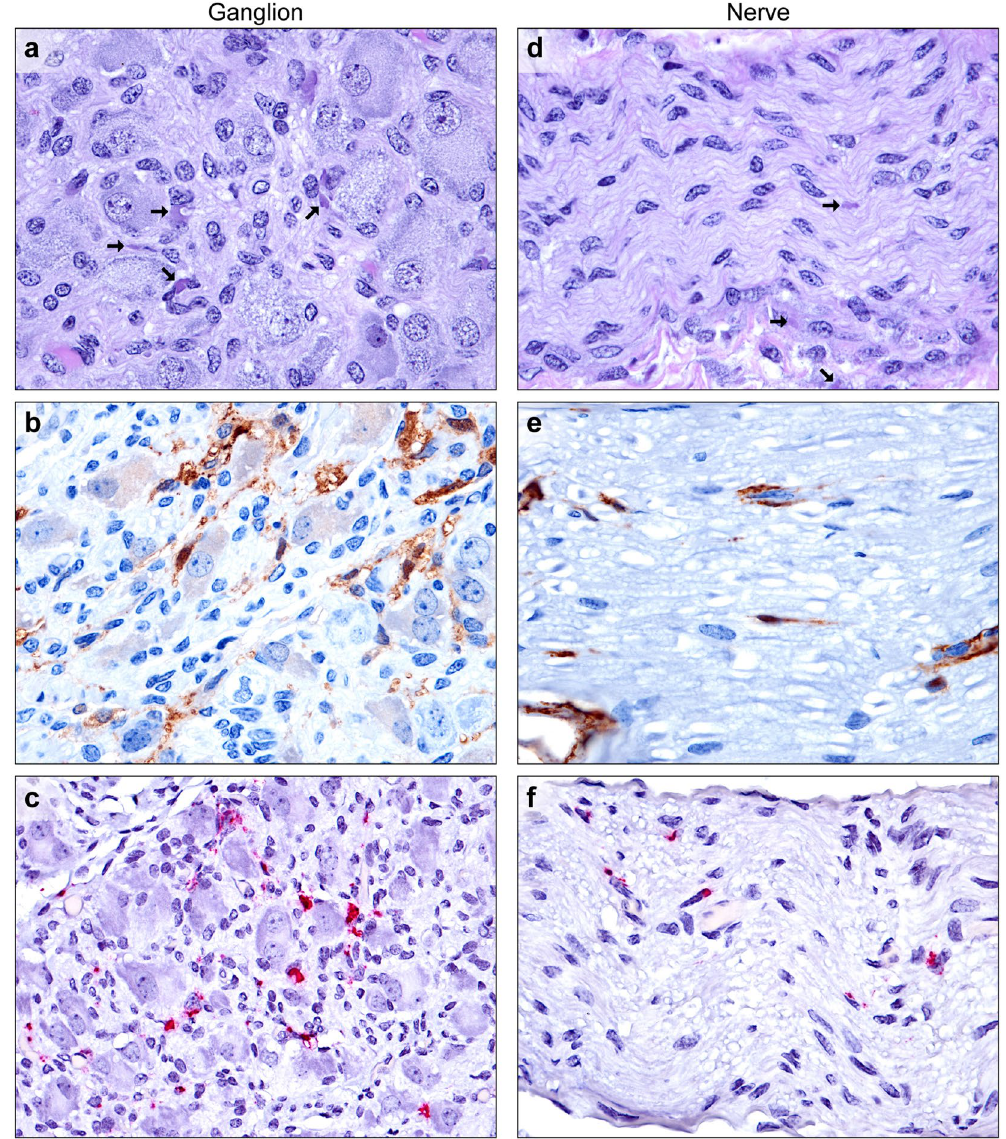
Figure 2. EBOV infection of paradrenal ganglia and peripheral medium myelinated nerves. ( a ) Low numbers of macrophages infiltrate between ganglion cells in the paradrenal ganglion. Viral intracytoplasmic inclusion bodies (arrows) are present within satellite cells, neurofibroblasts, Schwann cells, and macrophages (H&E). ( b ) Satellite cells, neurofibroblasts, Schwann cells, and macrophages, and intravascular plasma (EBOV VP40 IHC: DAB chromogen and hematoxylin). ( c ) Satellite cells, neurofibroblasts, Schwann cells, and macrophages in the ganglion (EBOV NP ISH: fast red chromogen and hematoxylin). ( d ) Viral intracytoplasmic inclusion bodies (arrows) are present within neurofibroblasts and Schwann cells within a nerve, with low numbers of perivascular infiltrating macrophages (bottom) (H&E). ( e ) Rare infected Schwann cells and neurofibroblasts within a myelinated nerve (EBOV VP40 IHC: DAB chromogen and hematoxylin). ( f ) Low numbers of Schwann cells, neurofibroblasts, and infiltrating macrophages within a myelinated nerve (EBOV NP ISH: fast red chromogen and